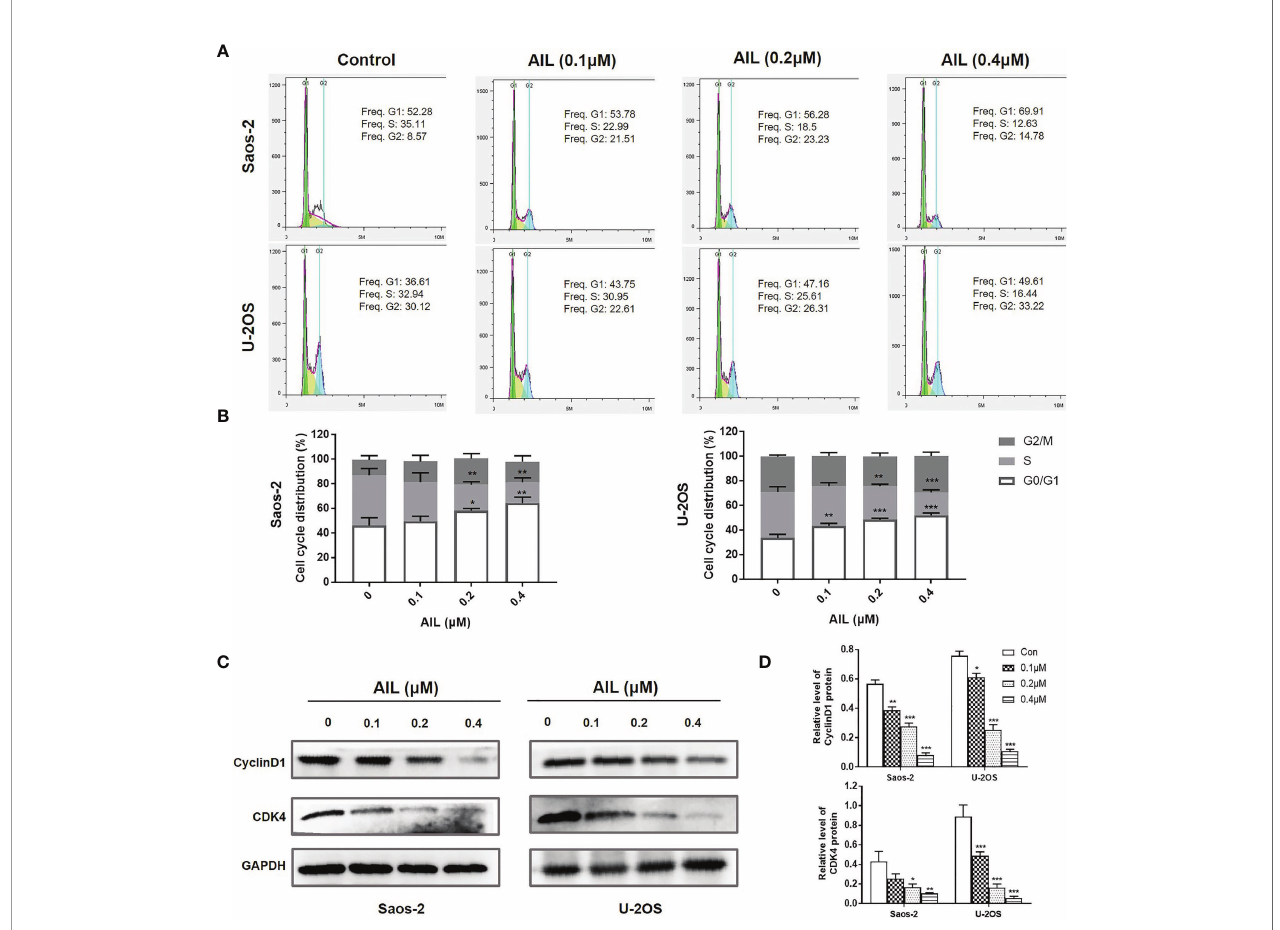
FIGURE 4 | AIL blocked G1-S cell cycle transition in OS cells. (A) Cell cycle pro fi les were measured by fl ow cytometry following treatment of the cells with various concentrations of AIL (0, 0.1, 0.2 or 0.4 m M) for 24 h. (B) The S phase was signi fi cantly decreased, while the G1 phase was signi fi cantly increased in Saos-2 and U- 2OS cells after AIL treatment (* P < 0.05, ** P < 0.01, *** P < 0.001 compared with the control). (C) The expression of cell cycle-related protein CyclinD1 and CDK4 was determined by Western blot assay. (D) The protein levels were evaluated by ratio values quanti fi ed from protein bands of each marker versus GAPDH (* P < 0.05, ** P < 0.01, *** P < 0.001 compared with the